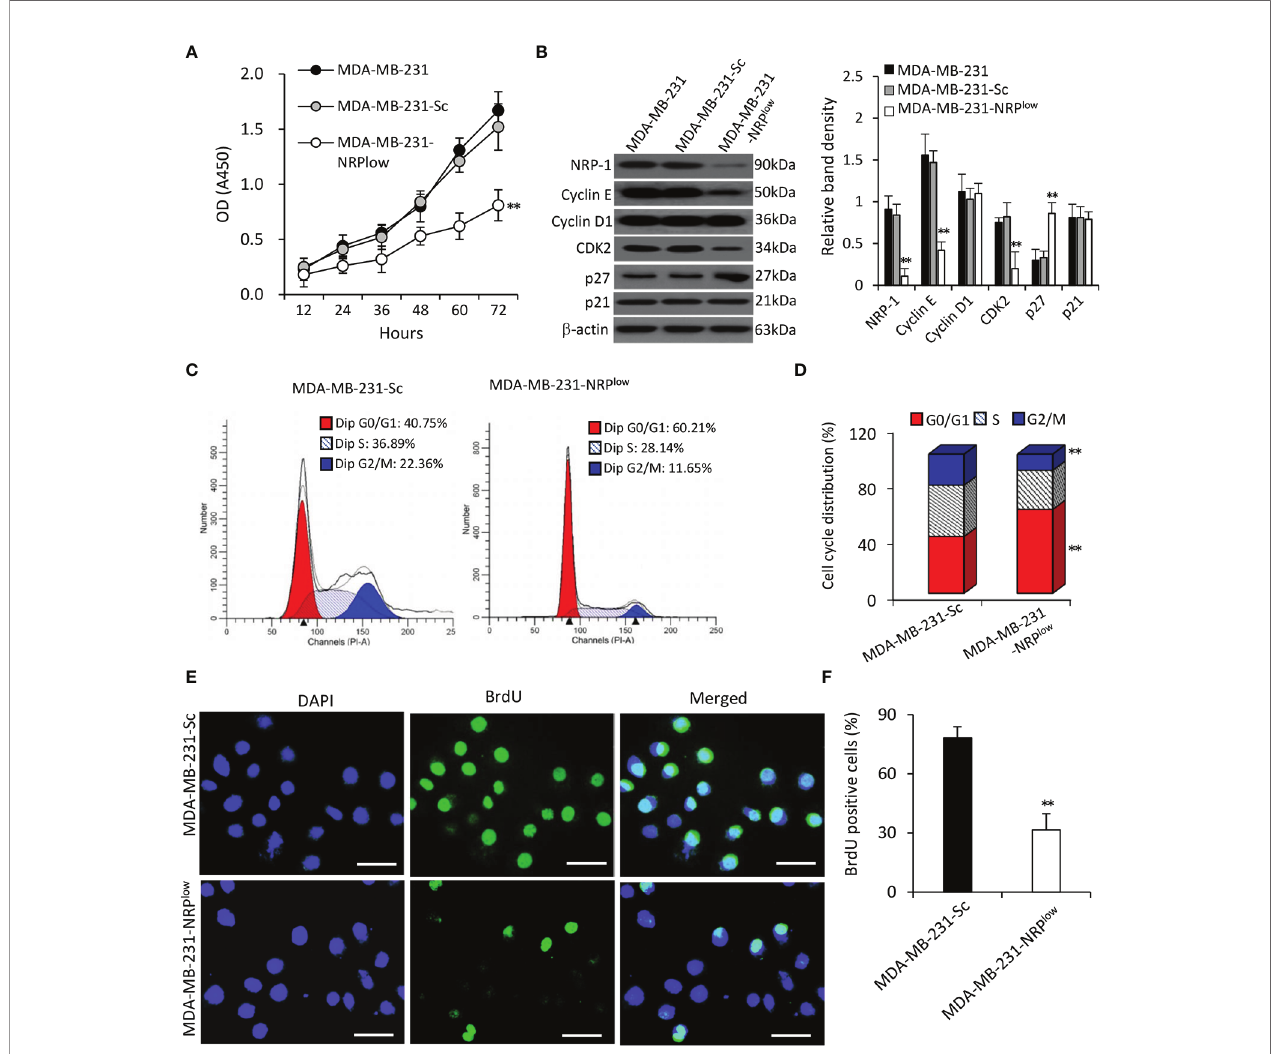
FIGURE 2 | Depletion of NRP-1 inhibits the proliferation of MDA-MB-231 cells. (A) MDA-MB-231, MDA-MB-231-Sc and MDA-MB-231-NRP low cells were cultured and the optical density (OD) was determined at indicated time points. (B) Cells were subjected to Western blot analysis for detecting the expression of proliferation- related proteins. Band density was normalized to b -actin. (C – F) MDA-MB-231-Sc and MDA-MB-231-NRP low cells were cultured for 48 h. (C, D) Cell cycle distribution was detected by fl ow cytometry (C) and percentages of cells at different phases were charted (D) . (E, F) BrdU incorporation assay was employed to detect cell proliferation. Representative images were taken from 4 ’ ,6-diamidino-2-phenylindole (DAPI)-stained nuclei of all cells (blue, left column), BrdU-stained nuclei of proliferating cells (green, middle column), and merged photographs (right column). Magni fi cation bar = 20 µm. (F) The percentage of BrdU-positive cells was plotted. “ **P < 0.001 ” [one-way ANOVA with a Tukey post-hoc test in (A, B) , t-test in (D, F) ] indicates a signi fi cant difference from MDA-MB-231-Sc